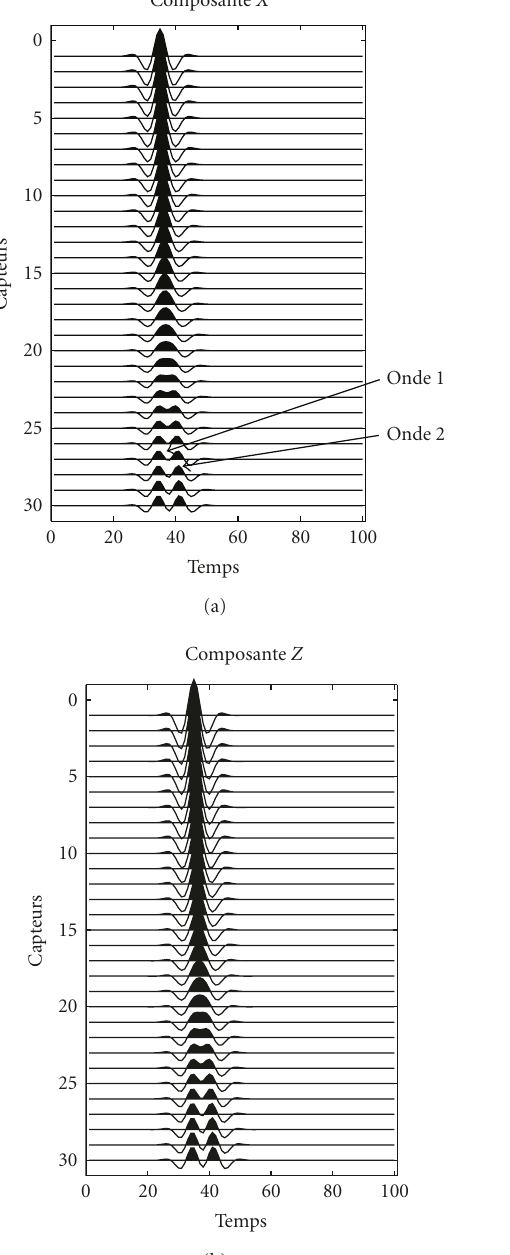
Figure 15: Model of two waves with close DOAs.